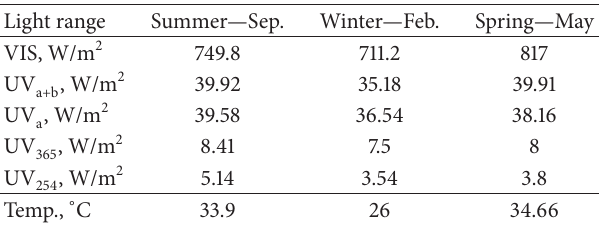
Table2:Averagelightintensityandtemperatureofdifferentseasons in Miao-Li,